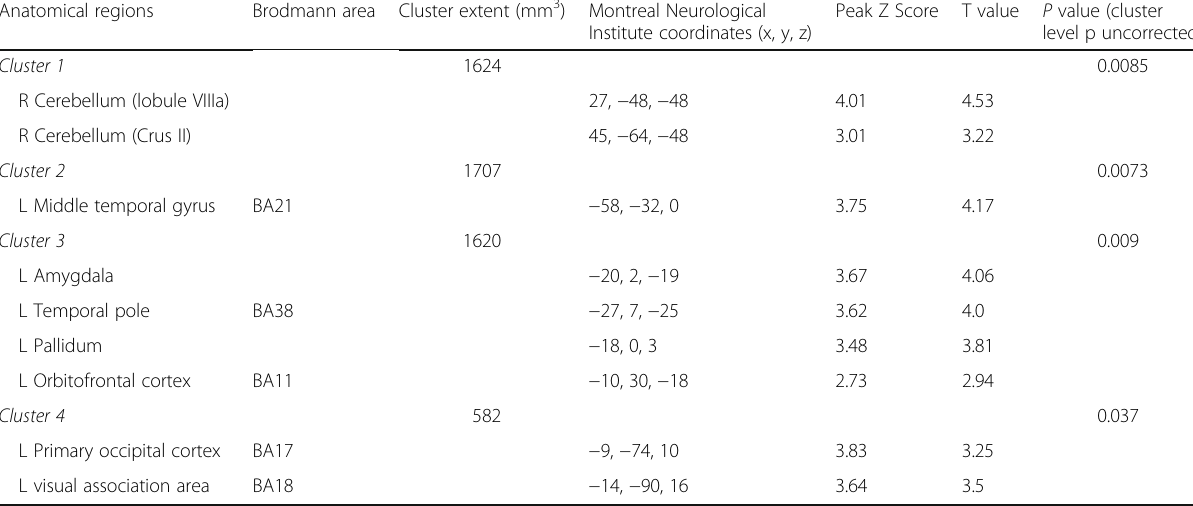
Table 3 Clusters of significant gray matter reduction in patients with chronic migraine vs. healthy controls using uncorrected maps at p <